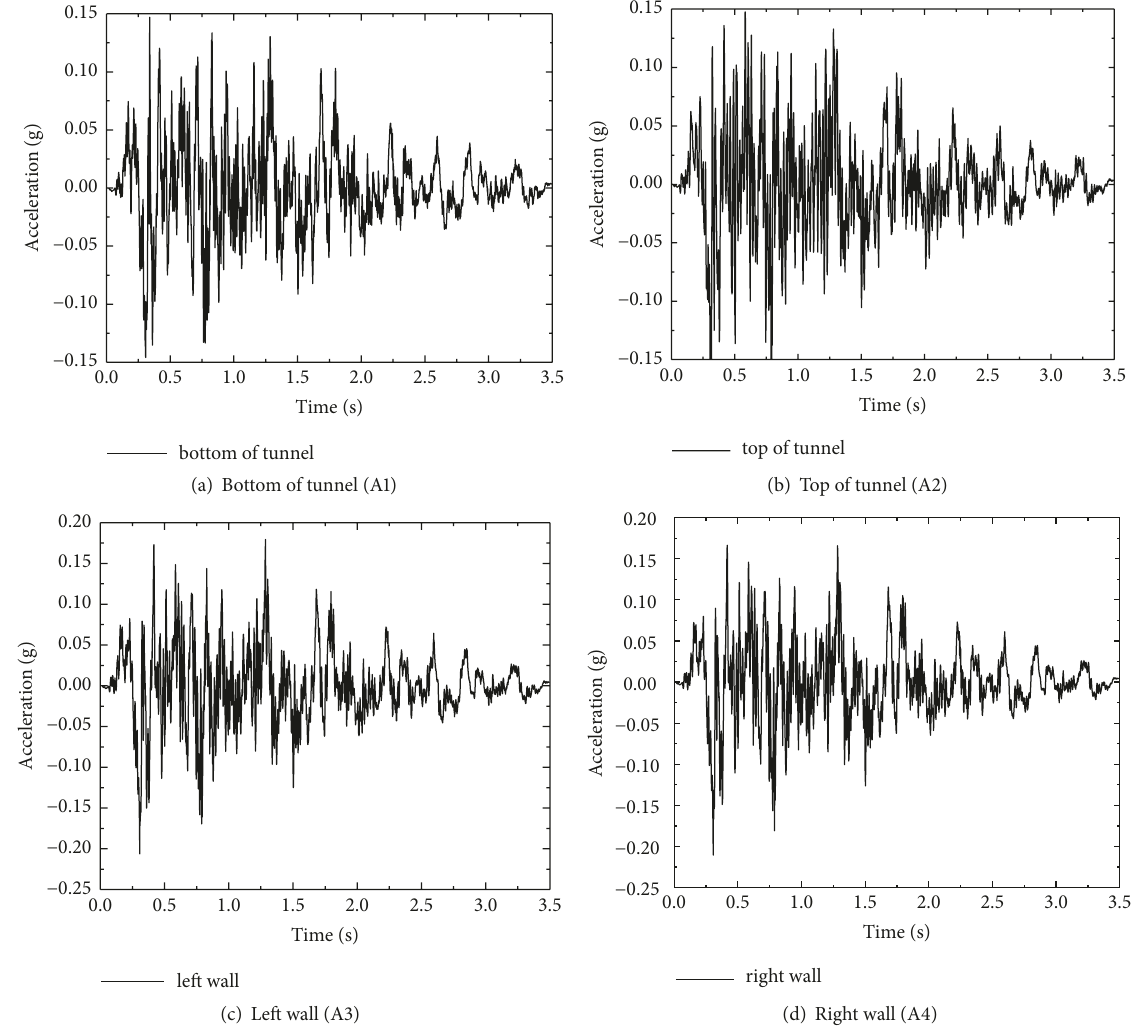
Figure 11: Acceleration time history curve of